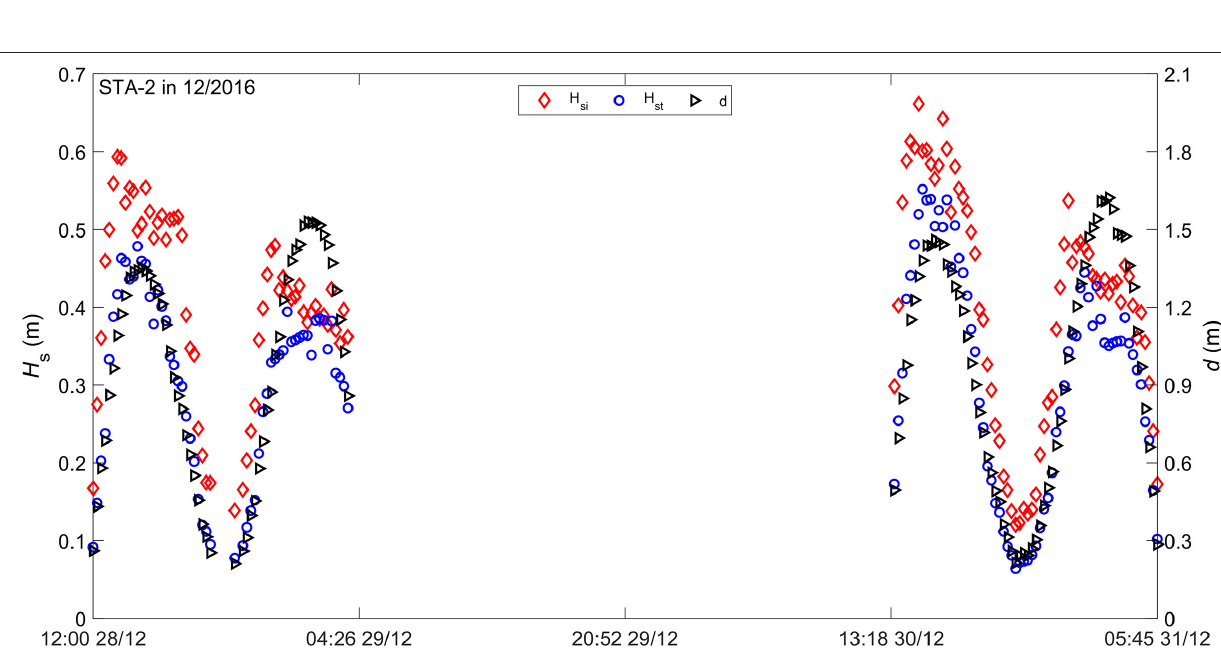
Frontiers in Marine Science |